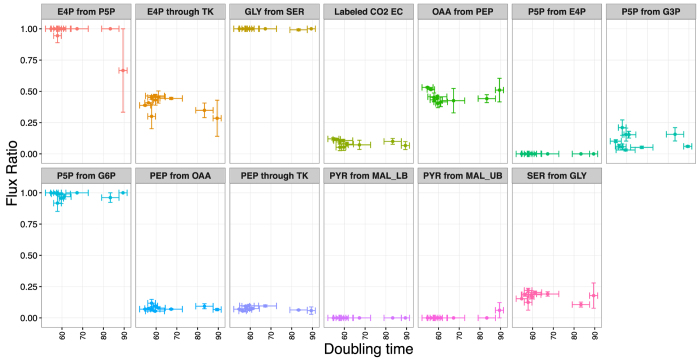
Flux ratios versus doubling times.13 different flux ratios were measured for varying Na+ and Mg2+ concentrations (Supplementary Figure 34). Here, these flux ratios are shown as a function of the corresponding doubling times. The specific fluxes considered and their shorthand labels as used here are defined in Ref. 35. There was no significant association between any of the flux ratios and doubling time after correction for multiple testing (Supplementary Table 14).